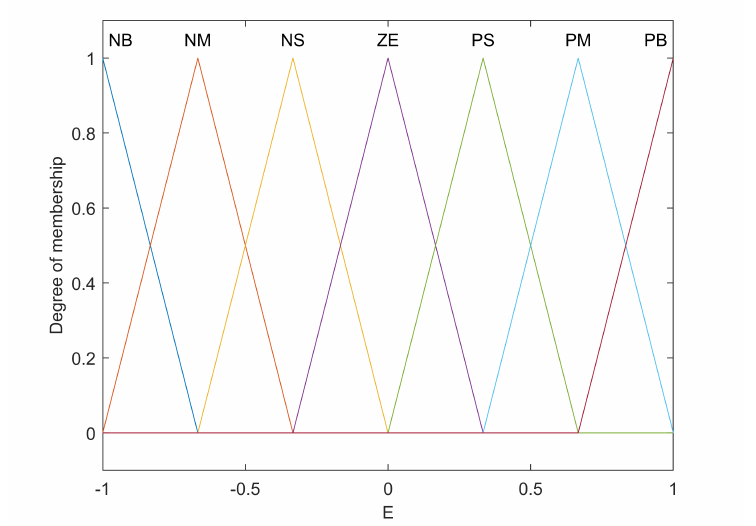
Figure 10. Inputs e, ec and Output u.